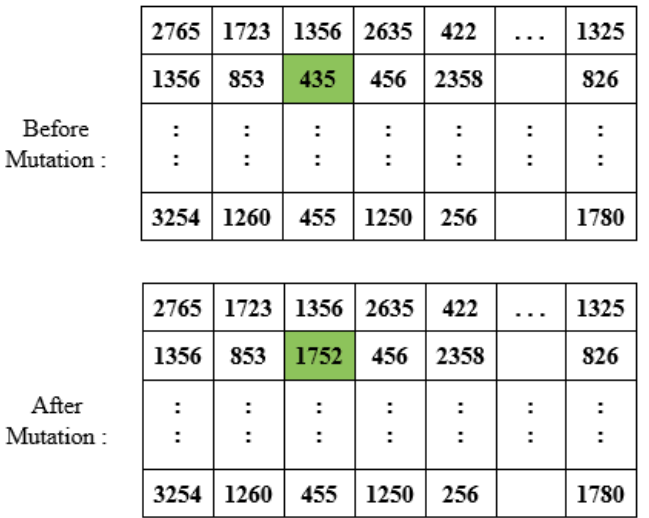
Fig. 11. Value swap mutation operator for the brit value